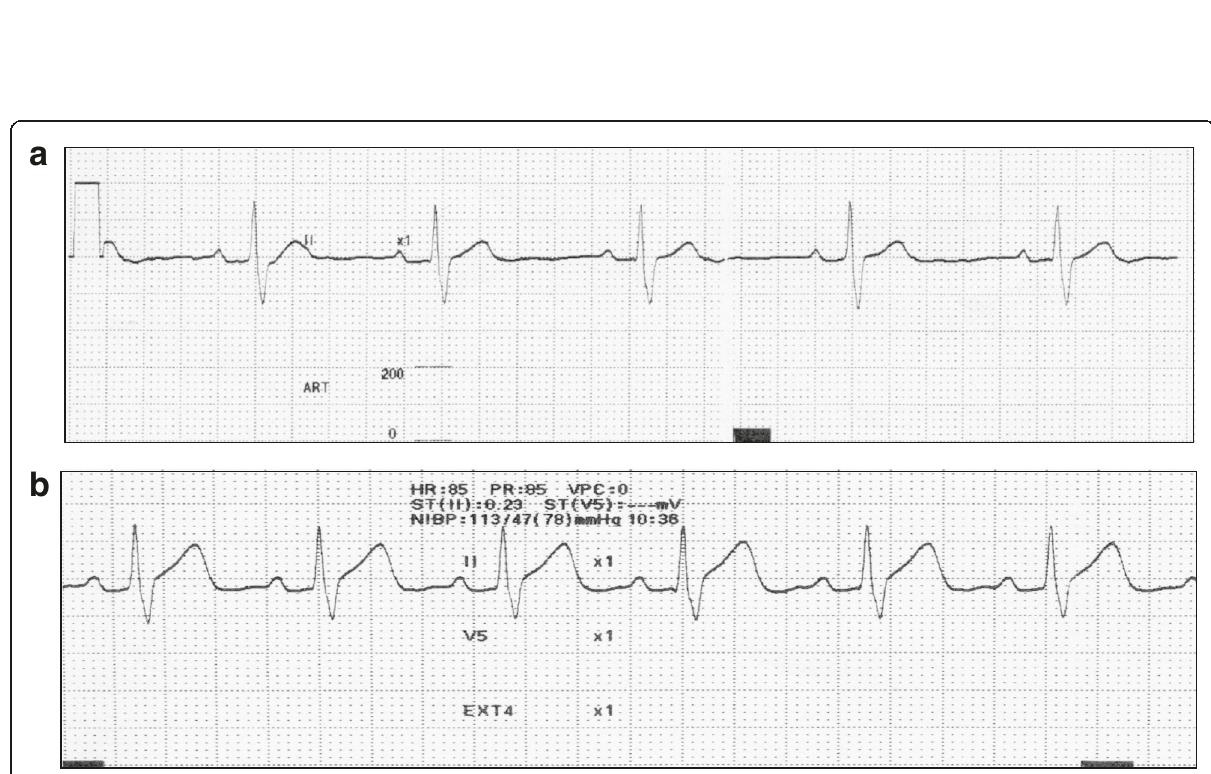
Fig. 4 Electrocardiographic changes after CPR. a After cardiopulmonary resuscitation: HR=50 bpm. b Before leaving the operation room: HR=95